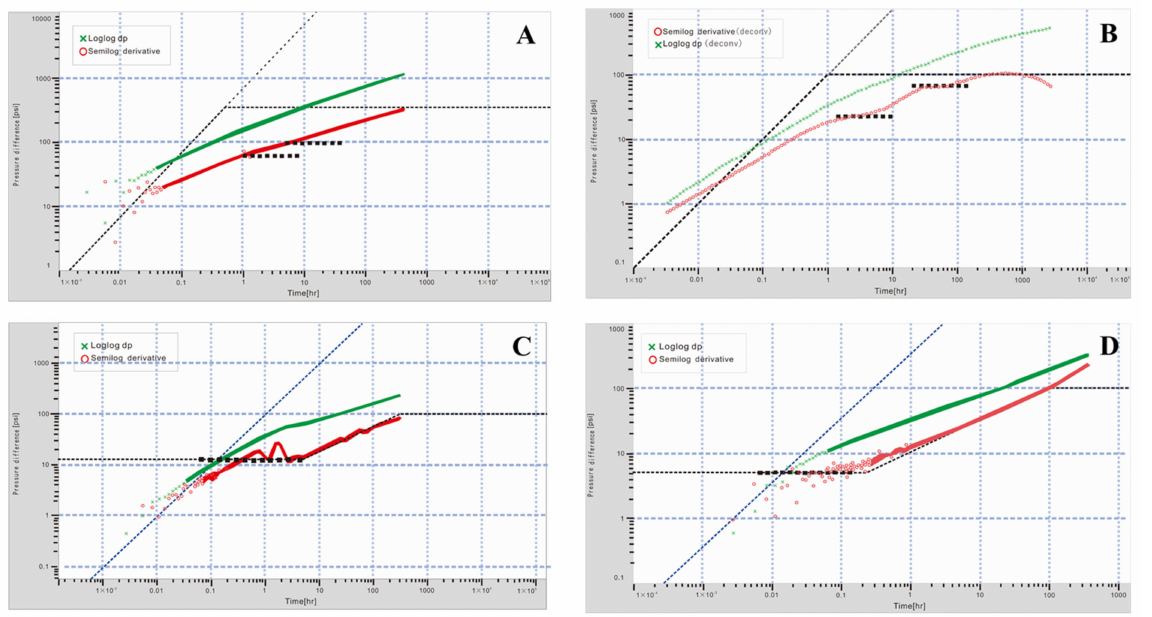
Figure 10. The differential of pressure curves from four horizontal wells. ( A ) A7-5H; ( B ) A5-2H; ( C ) A0-3H; ( D )